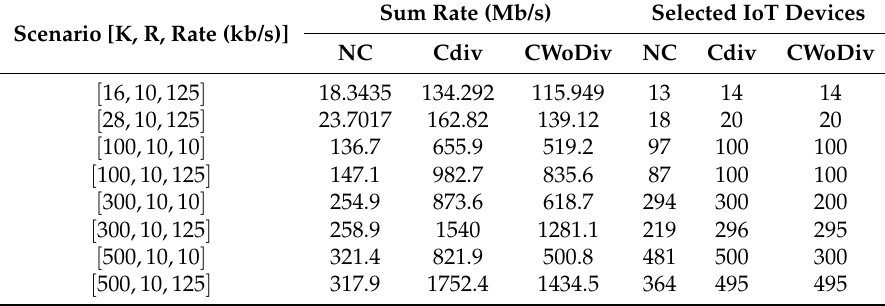
Table 3. Simulation results for multiple scenarios, where K is number of IoT devices and R means number of